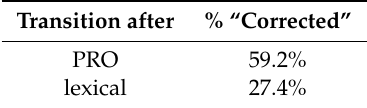
Table 3. Results of close-shadowing: mixed Palenquero-Spanish